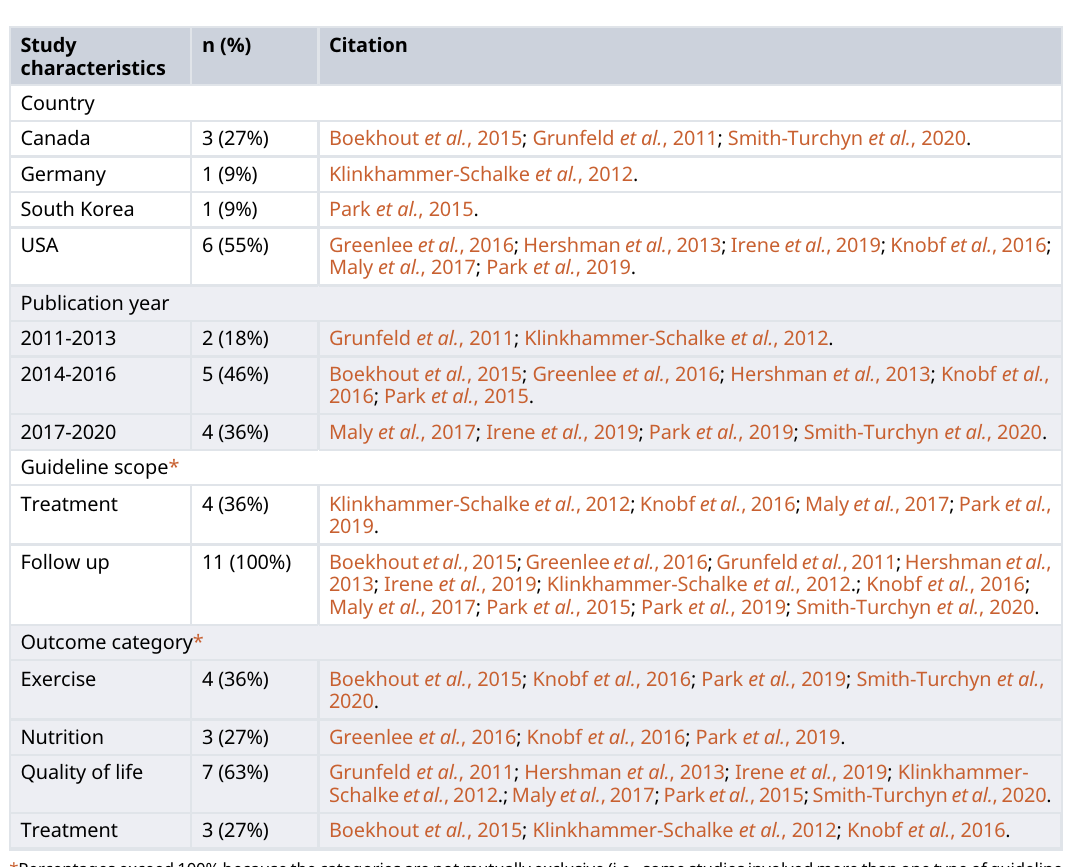
Table 2. Characteristics of all included studies